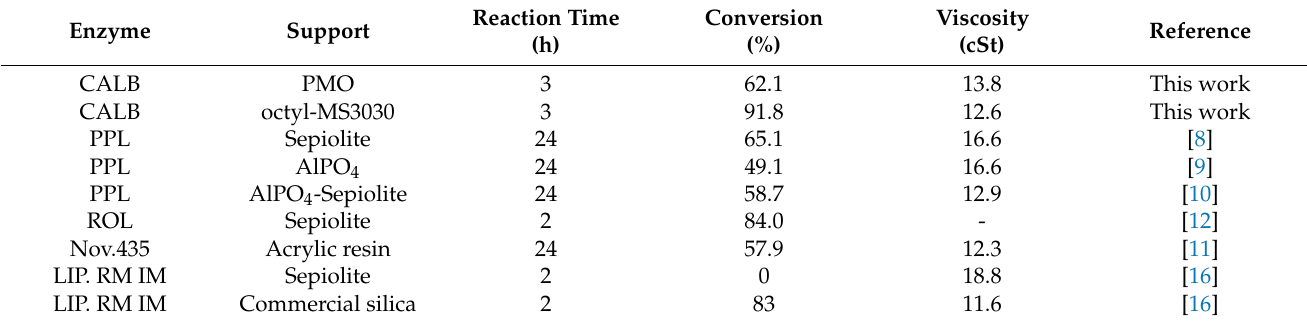
Table 2. Reaction time, conversion values and viscosity of the biofuel obtained on the solids investigated herein and, on several catalysts previously reported by our research